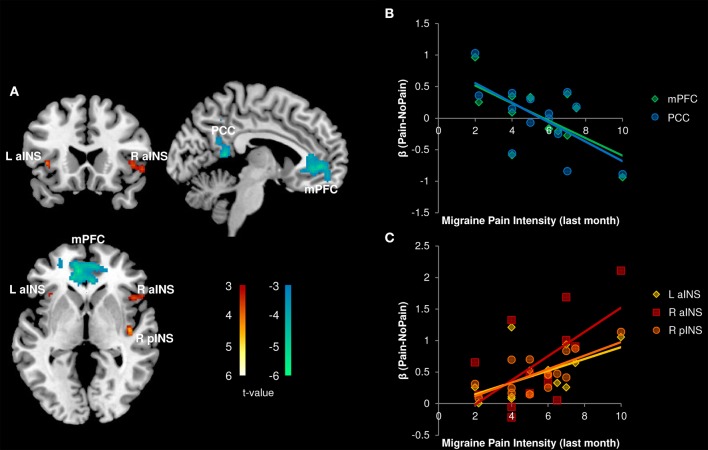
Correlation with Migraine Pain Intensity (n = 14). (A) Whole brain correlations conducted on the [Pain (P1+P2) > No Pain (P0)] contrast, p < 0.005, cluster-level correction p < 0.05. Insula clusters displayed at puncorrected < 0.005. (B) Extracted activity from medial prefrontal cortex (mPFC), and posterior cingulate cortex (PCC) clusters plotted against migraine pain intensity ratings for the last month. (C) Extracted activity from left anterior insula (L aINS), right anterior insula (R aINS), and right posterior insula (R pINS) clusters plotted against migraine pain intensity ratings for the last month. Warm colors, positive correlation; Cool colors, negative correlation.